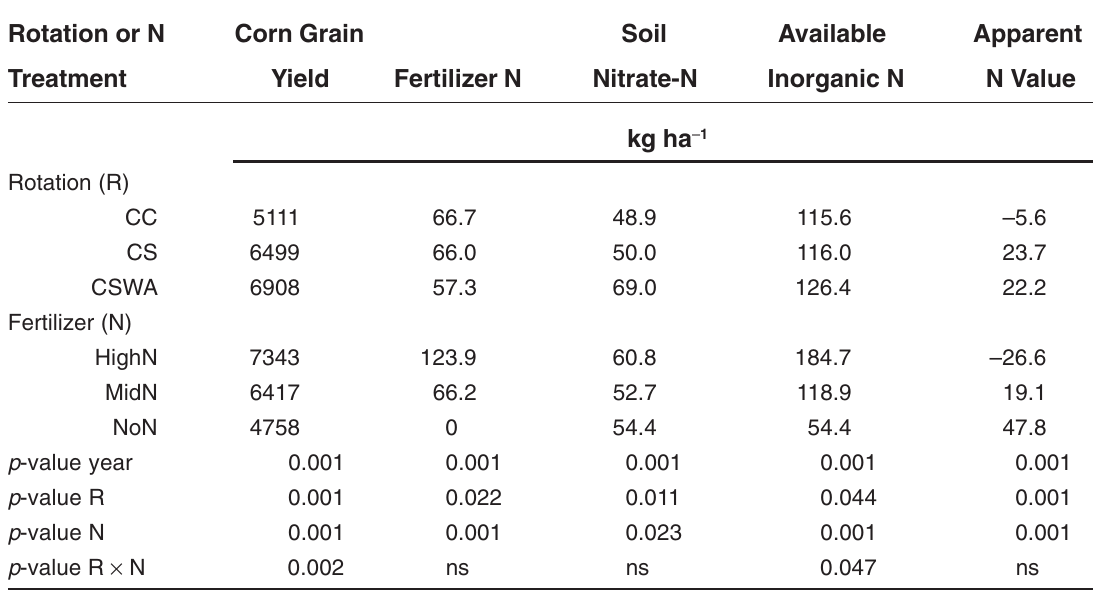
Average Corn Grain Yield, Applied Fertilizer N, Autumn Soil Nitrate-N, Available Inorganic N, and Apparent N Value (Based on Grain Yield) for